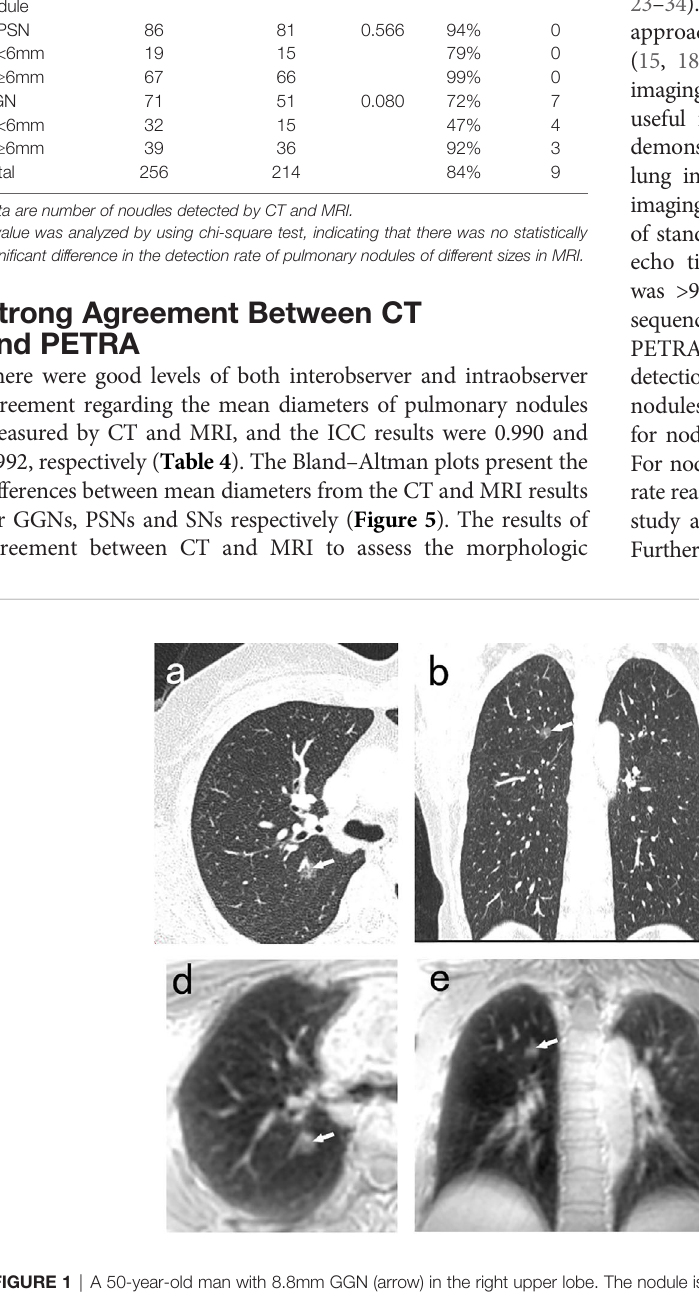
FIGURE 1 | A 50-year-old man with 8.8mm GGN (arrow) in the right upper lobe. The nodule is well depicted on the CT axial (A) , coronal (B) , and sagittal (C) image, and on the PETRA sequence axial (D) , coronal (E) , and sagittal (F) image. The arrows represent the locations of